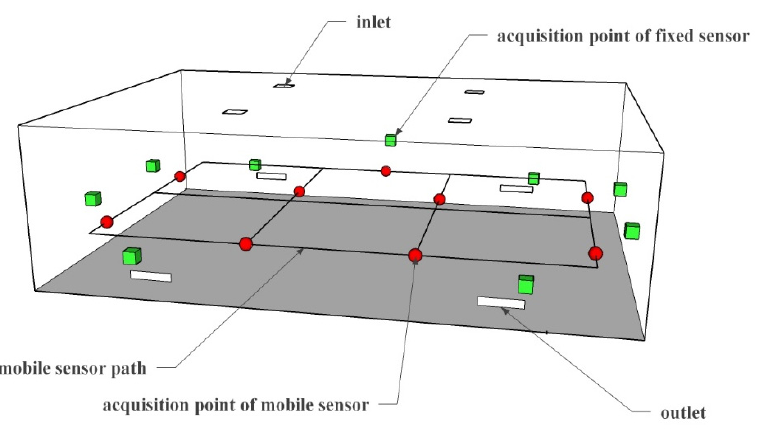
Figure 8. Acquisition points of fixed sensors and mobile sensors.